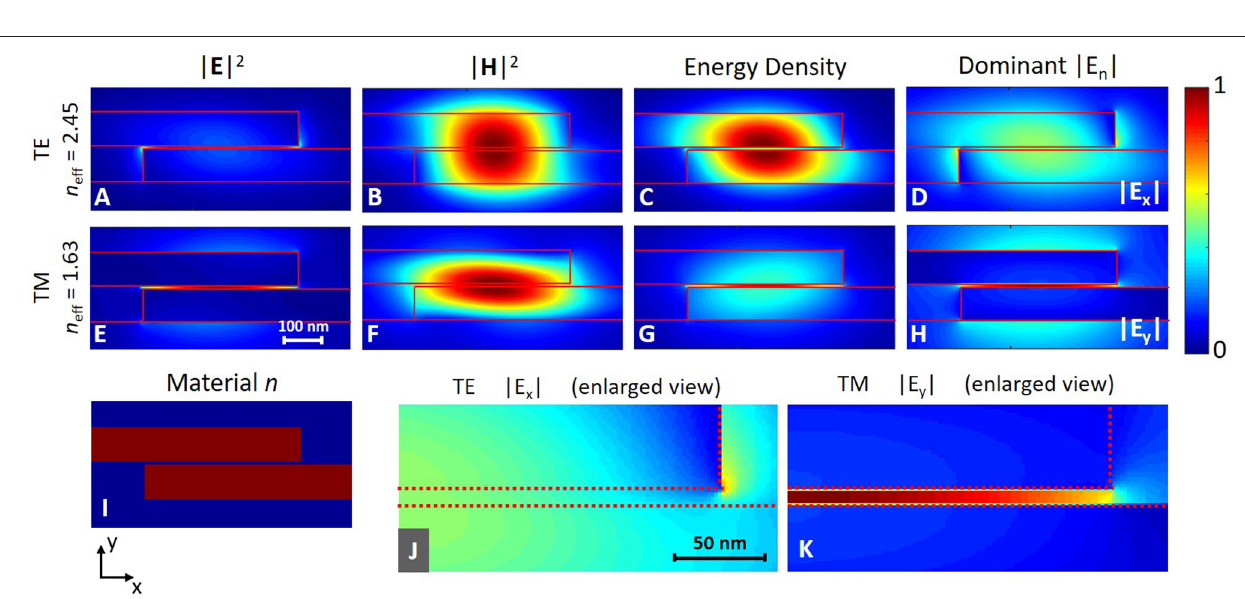
FIGURE 1 | Top-down (A,B) and cross-sectional (Ai,Aii,Bi,Bii) view of partially suspended horizontal-slot fin-waveguide design, demonstrating aligned, m = 0 (A,Ai,Aii) and maximal misaligned, m = 0.5 (B,Bi,Bii) structures.